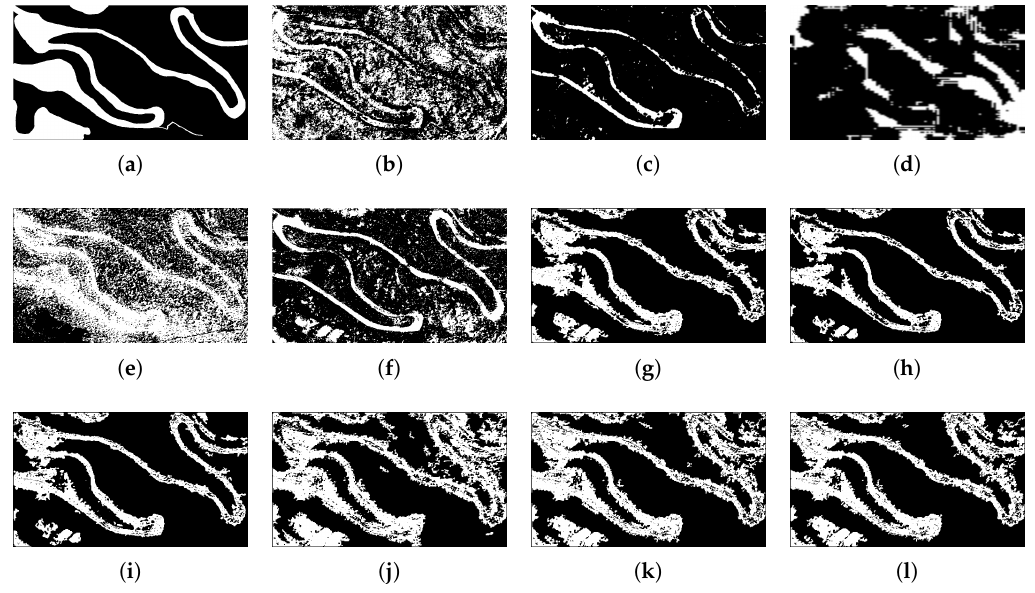
Figure 13. Change detection results of the Forest Dataset. ( a ) Ground truth; ( b )